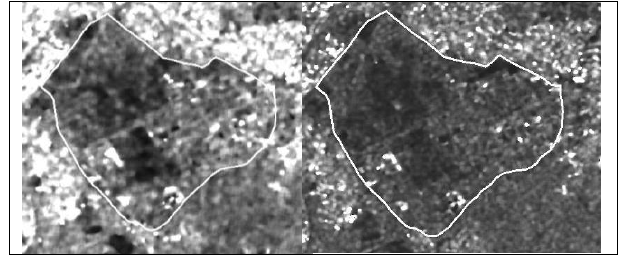
Figure 2. Sigma Naught (a) 2 nd July 2018 (b) 14 th July 2018